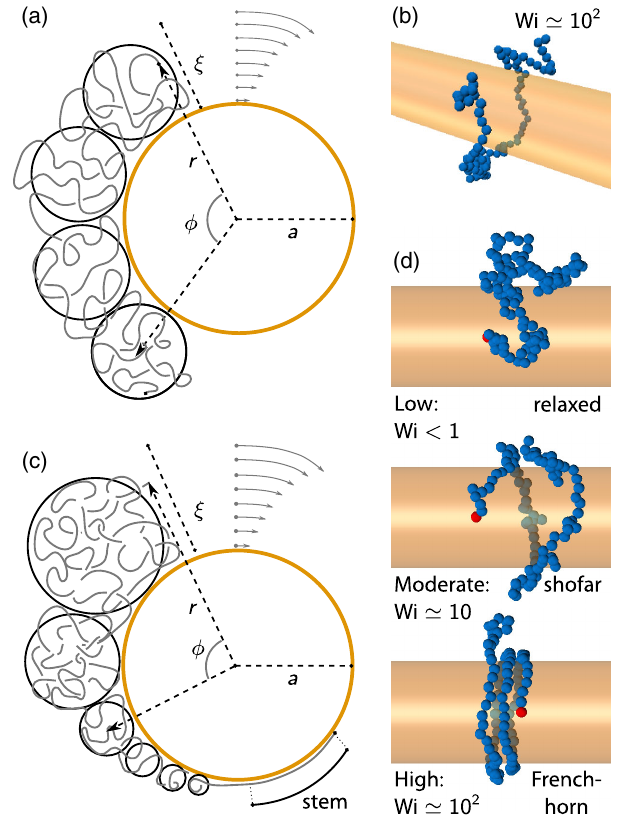
FIG. 1. (a) The untethered DNA system: The rotating cylinder of radius a generates a flow profile v ϕ ð r Þ , which shears the DNA and deforms it. A model for this is a procession of identical blobs of size ξ . (b) Simulation snapshot portraying a typical steady-state conformationofan untetheredDNA chain. (c) The tethered system with the French-horn DNA conformation: The blob size ξ is a function of angle ϕ from the untethered end. For sufficiently large Weissenberg numbers Wi, a portion of the DNA is fully stretched into a stem section, while the rest is in a horn conformation. For smaller Wi, there is no stem and the polymer is in the shofar conformation. (d) Simulation snapshots portraying typical steady- state tethered conformations. Increasing Wi changes the state from relaxed, to shofar, to French-horn conformations. Sufficiently long, rapidly rotated chains wrap around the circumference forming a rim of strongly stretched